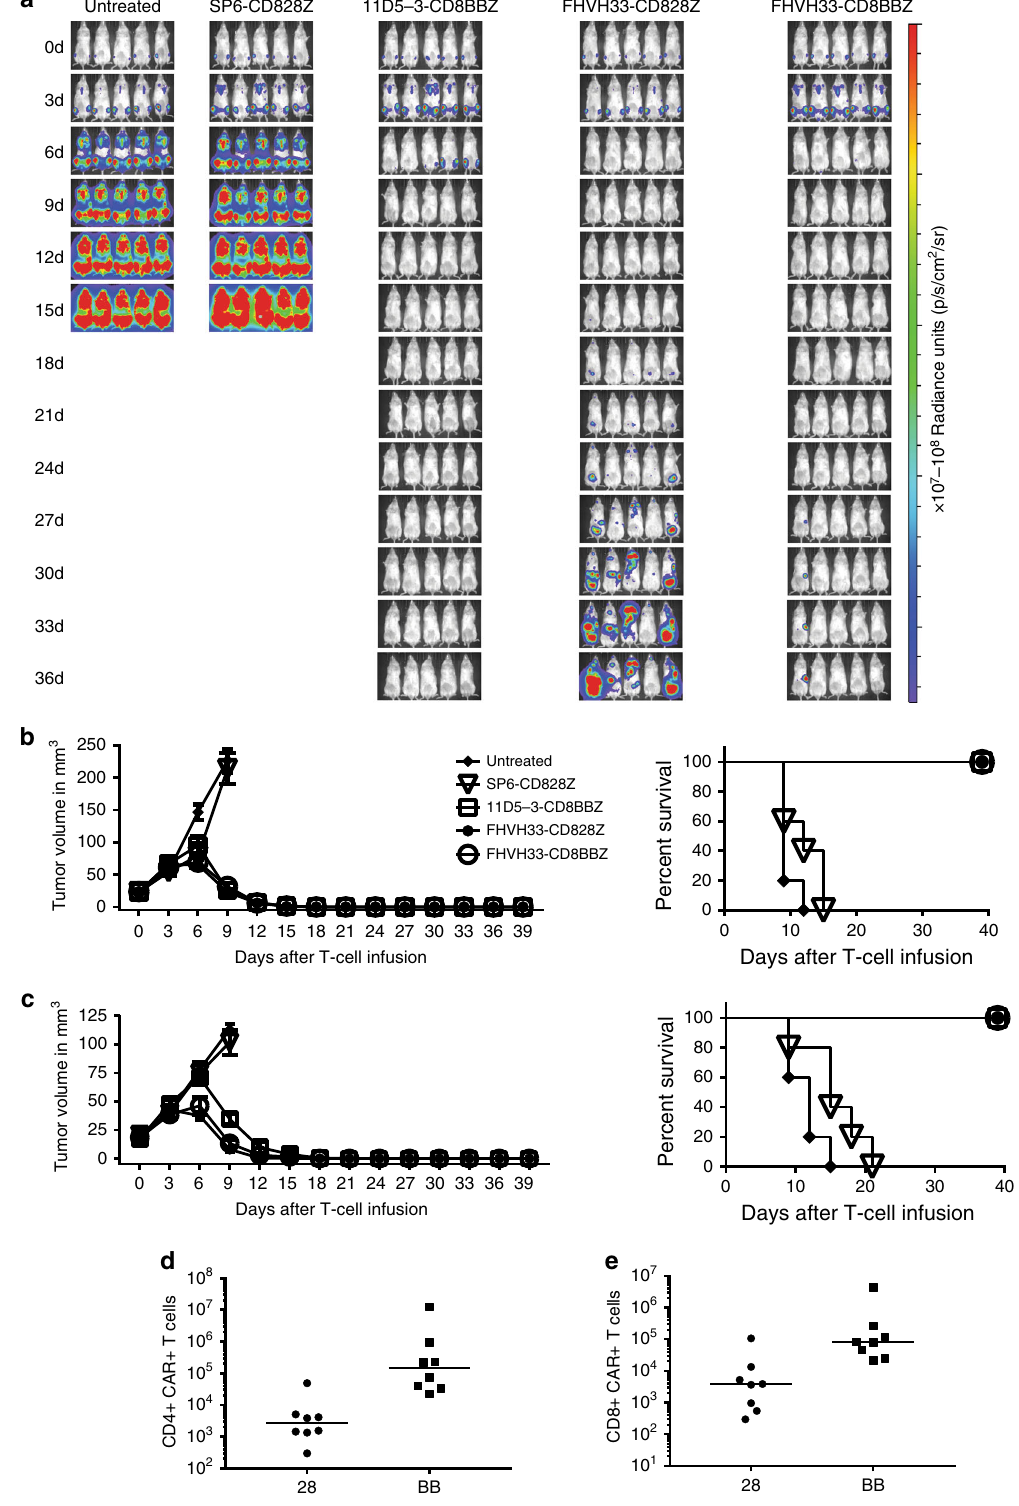
sequences and by using less complex antigen-binding domains, such as heavy-chain-only domains. Second, single heavy-chain- only domains are smaller than scFvs, and limiting the size of better gene expression by transduced T cells 34 . Limiting the